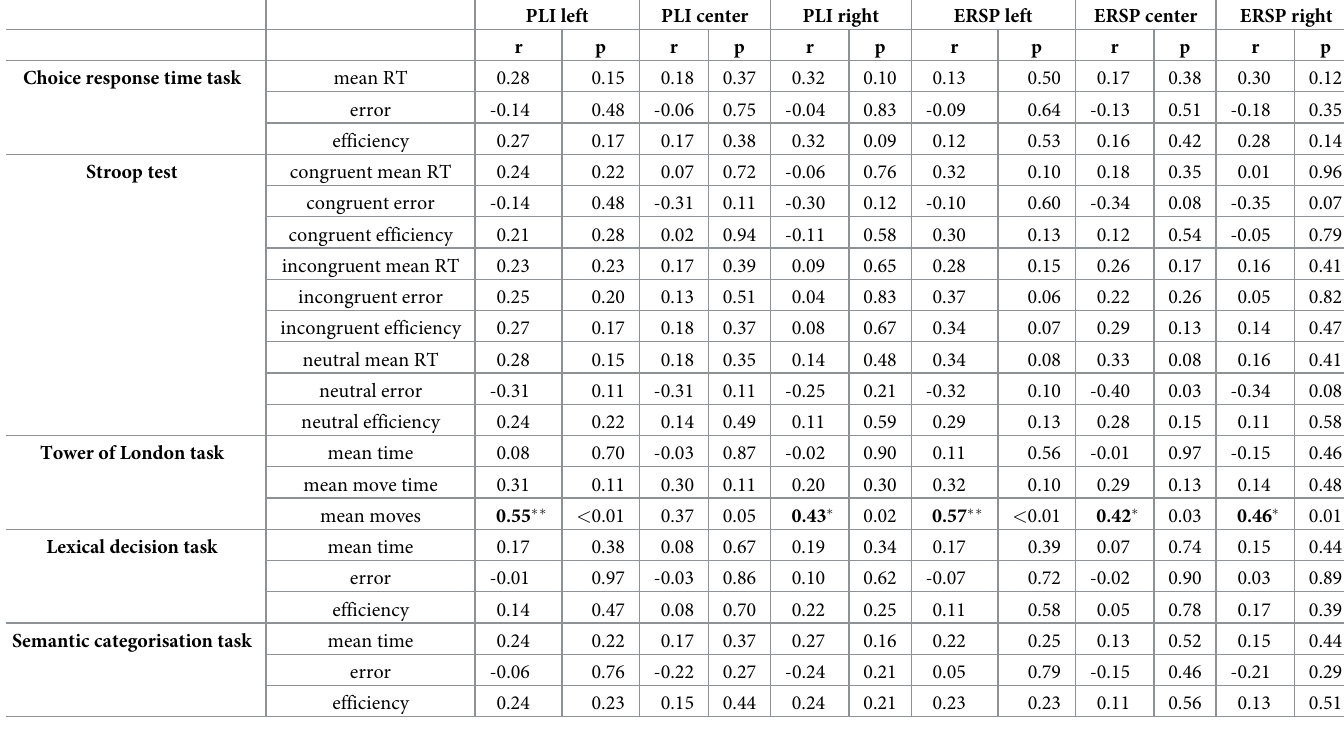
Table 3. Correlation coefficients and corresponding p values between 40-Hz ASSR parameters and cognitive task